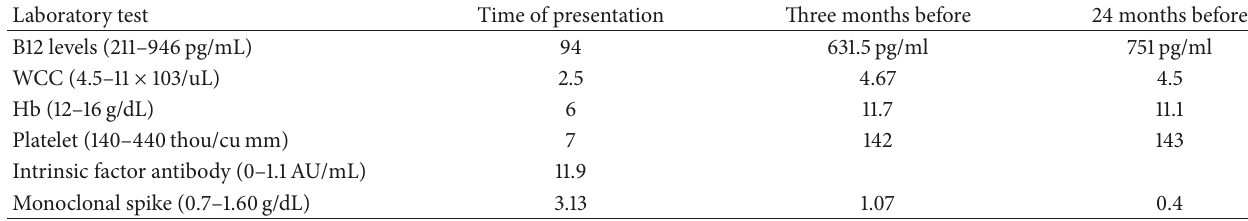
Table 1: Displaying the trend of B12 levels, CBC, and paraprotein levels.